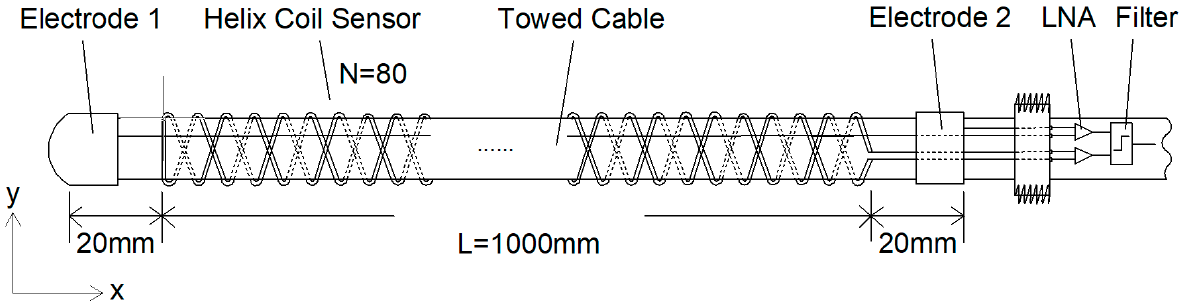
Figure 1. Helix coil sensors structure conformal to the towed antenna.